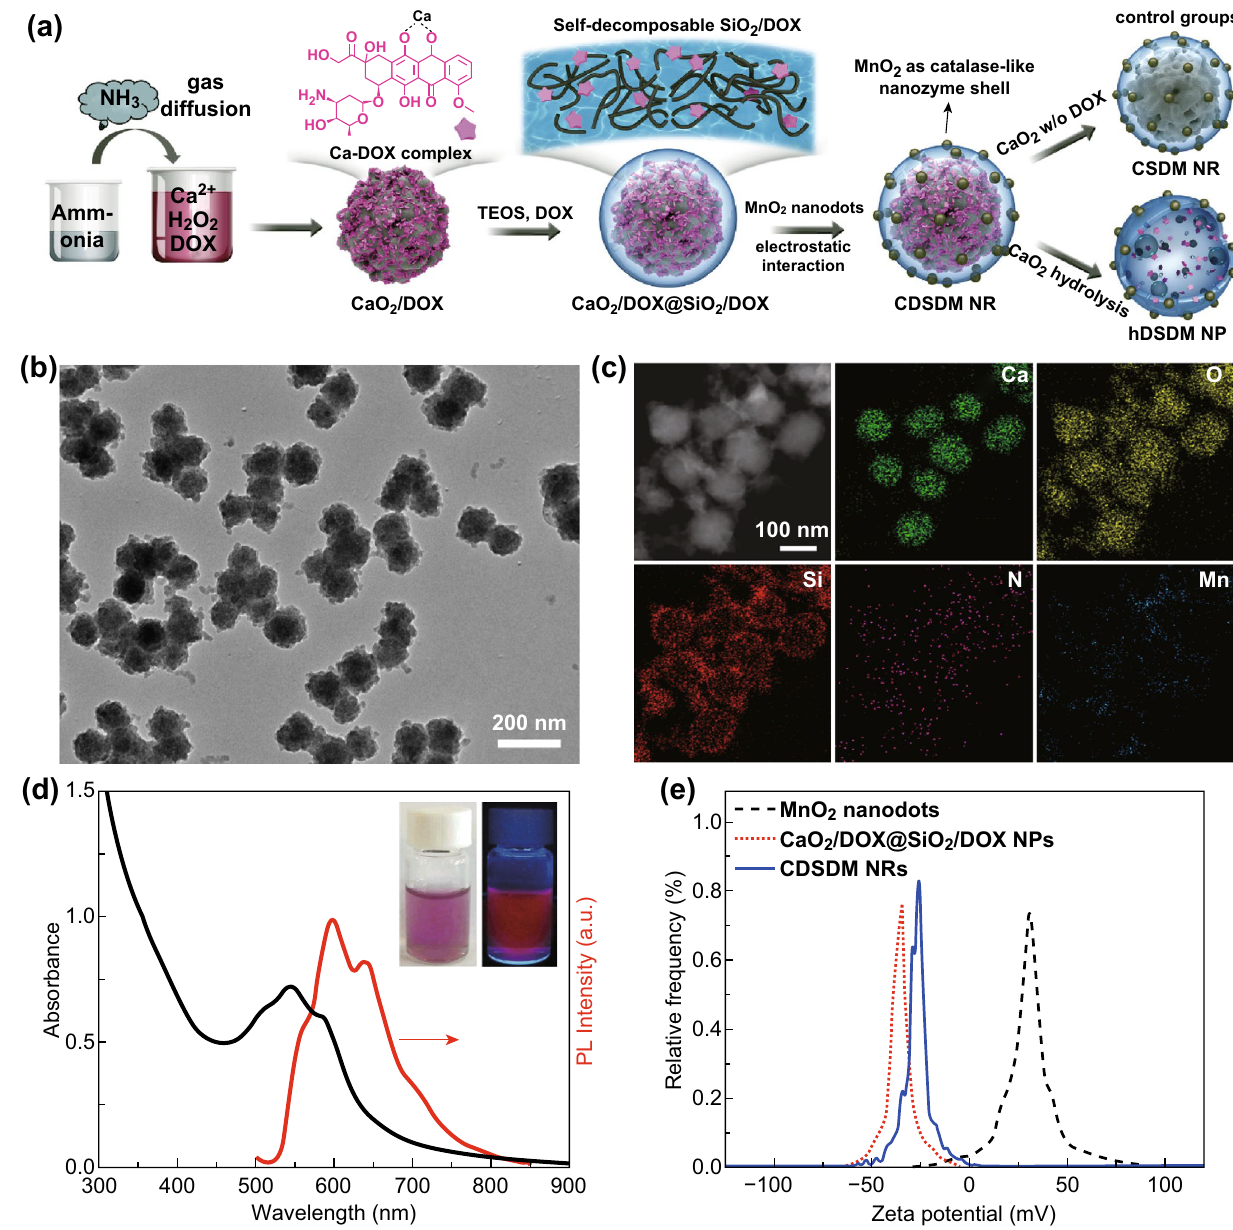
Fig. 1 a Schematic illustration of the preparation of CDSDM NRs. For the control groups, the CaO 2 @SiO 2 /DOX‑MnO 2 is named as CSDM NRs; after completely hydrolyzing CaO 2 core in the CDSDM NRs, the hollow nanoparticle is named as hDSDM NPs. b Representative TEM image and c elemental mapping of CDSDM NRs. d UV–Vis absorption and photoluminescence spectra of CDSDM NRs. Insets are photographs of CDSDM NRs taken under (left) room light or (right) 365 nm light irradiation. e Zeta Potential of MnO 2 nanodots, CaO 2 /DOX@SiO 2 /DOX NPs and CDSDM